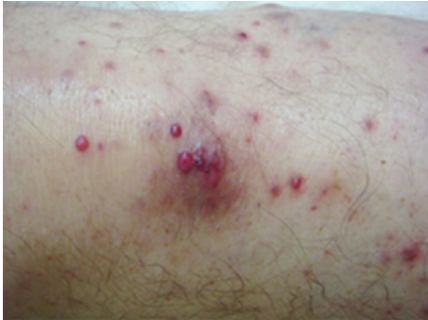
Figure 3: Polypoid granuloma pyogenicum-like lesion with ectatic, lobular vascular proliferation (hematoxylin-eosinstaining, 10 × ).